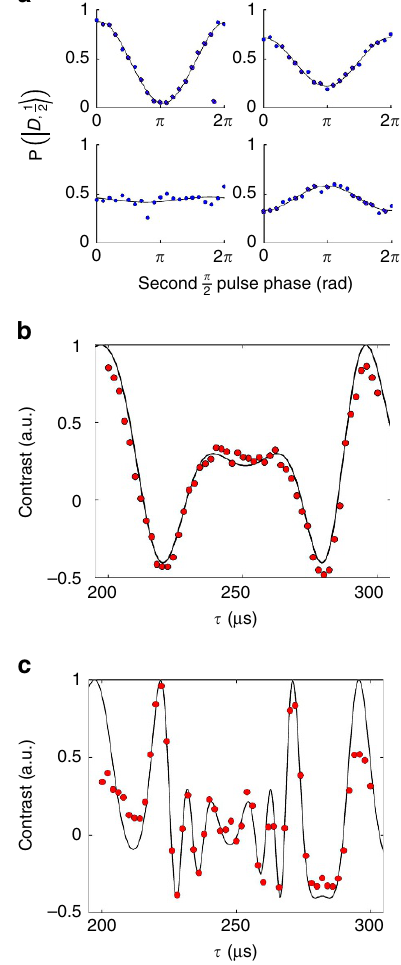
Figure 4 | Experiment results of a-synchronous force measurement. ( a ) Four different contrast fringes measured (blue circles) and fitted to data (solid line) at different modulation frequencies for n ¼ 10 echo pulses. As and x as the ion modulation frequency approaches the force modulation frequency p 2 l (1.013kHz) the phase variance increases and the fringe contrast decays. The last fringe (1.136kHz) shows partial re-phasing due to the topology of the Bloch sphere. ( b , c ) Measured contrast (red full circles) and a fit to theory (solid line) as a function of t with n ¼ 10, 20 echo pulses correspondingly. Each point on the plot corresponds to the contrast extracted from a measurement similar to a . The fit corresponds to equation (6). The calculated value for the ion motion amplitudes is x 0 ¼ 116 ± 3nm and x 0 ¼ 115 ± 4nm, and the corresponding force amplitudes are F 0 ¼ 8.54 ± 0.2 (cid:2) 10 (cid:3) 19 N and F 0 ¼ 8.47 ± 0.3 (cid:2) 10 (cid:3) 19 N for n ¼ 10, 20 pulses,